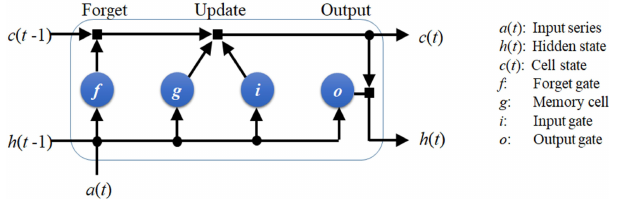
Figure 3. Schematic of the LSTM architecture. LSTM has a mem- ory cell, an input gate, an output gate, and a forget gate to control the information of the previous time to flow into the neural